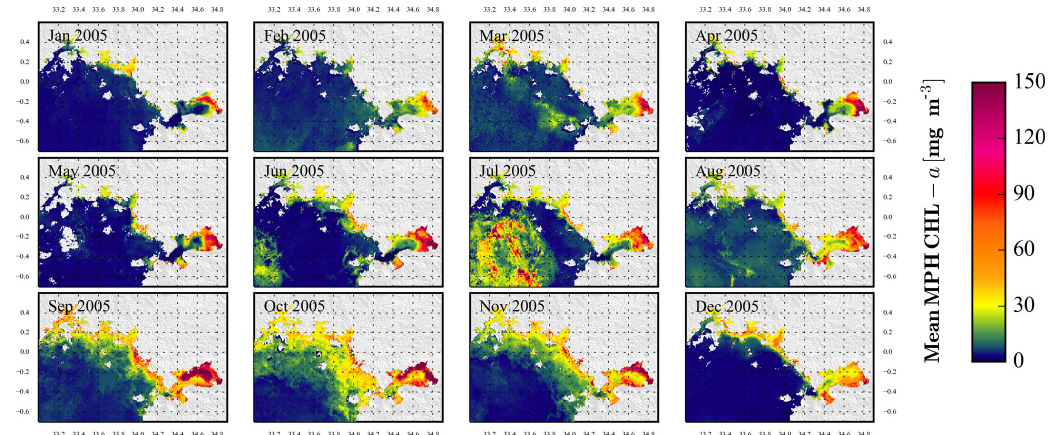
Figure 17. Monthly chl concentrations obtained with the Maximum Peak Height (MPH) algorithm in north-eastern Lake Victoria, 2005 ( chl_mph_mean